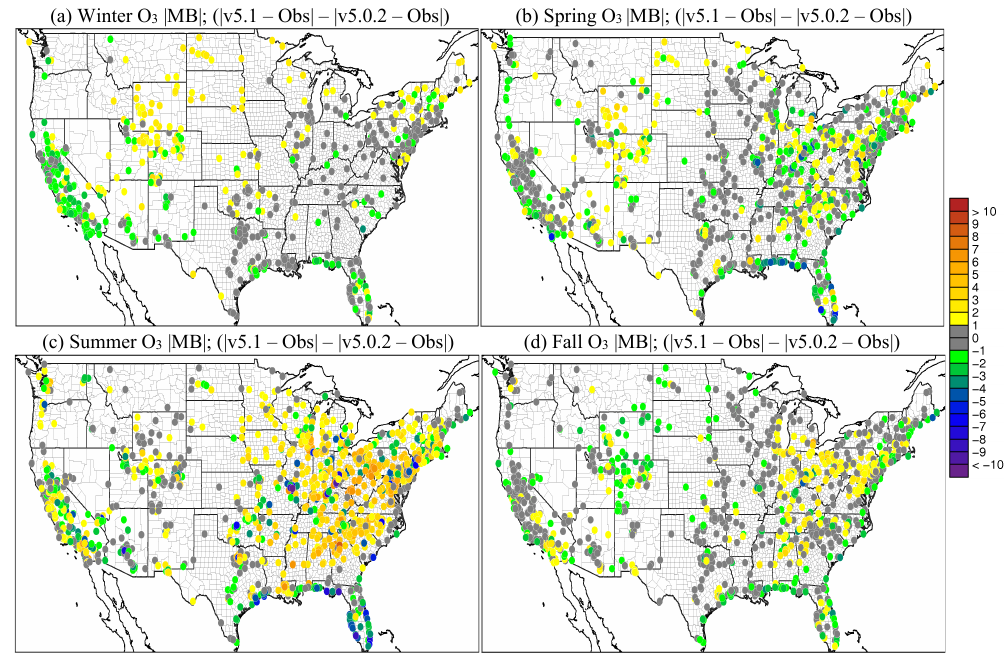
Figure 13: Difference in the absolute value of monthly average O 3 mean bias for a) winter (DJF) b) spring (MAM) c) summer (JJA) and d) fall (SON) Figure 13. Difference in the absolute value of monthly average O 3 (ppbv) mean bias for (a) winter (DJF), (b) spring (MAM), (c) summer between CMAQ v5.0.2_Base and v5.1_Base (CMAQv5.1_Base – CMAQv5.0.2_Base). All plots are in units of ppbV. Cool colors indicate a reduction in O 3 mean bias in v5.1 while warm color indicate an increase in O 3 mean bias v5.1. (JJA) and (d) fall (SON) between CMAQ v5.0.2_Base and v5.1_Base_NEIv1 (CMAQv5.1_Base_NEIv1–CMAQv5.0.2_Base). Cool colors indicate a reduction in O 3 mean bias in v5.1, while warm colors indicate an increase in O 3 mean bias